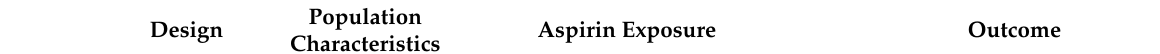
Table 6. Characteristics of publications discussing the correlation between aspirin and